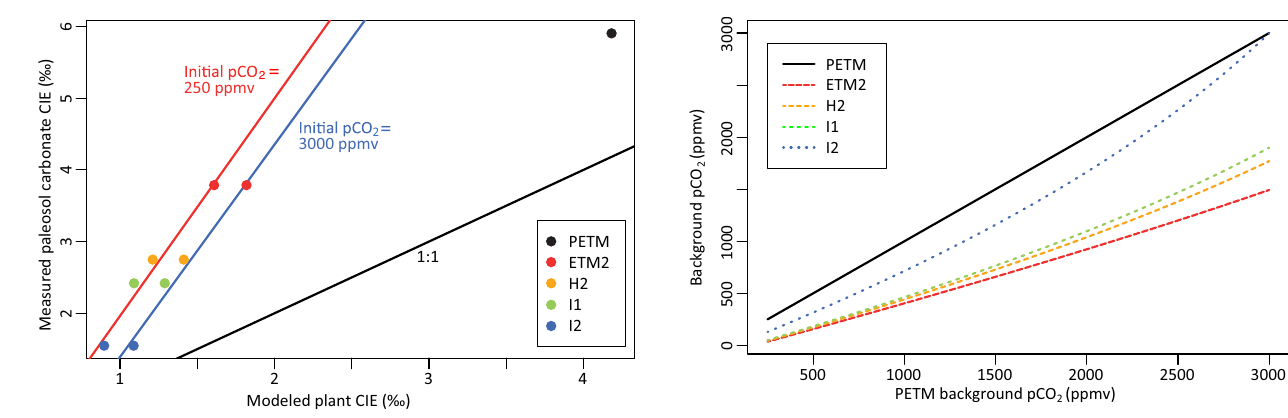
Figure 6. Modeled background p CO 2 conditions that result in lin- ear scaling of soil carbonate CIEs relative to the marine record across the five hyperthermals. For each event, change in photosyn- thetic 13 C discrimination is forced by a hyperthermal p CO 2 in- crease, constrained by the model calculations described in the text, over an event-specific background p CO 2 condition shown in the figure. The background values shown represent unique solutions where the change in photosynthetic discrimination among events re- solves the observed nonlinear scaling of terrestrial relative to marine records. Note that this requires a >50% decrease in background p CO 2 for most of the post-PETM hyperthermals relative to the